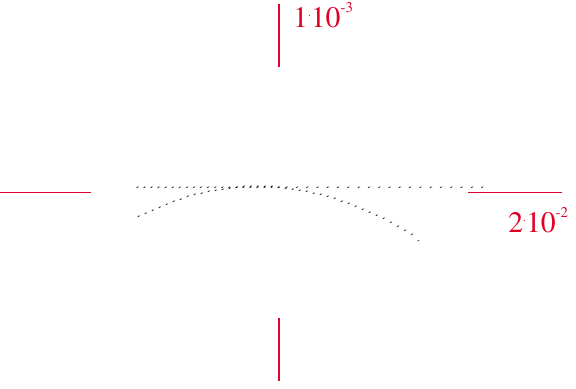
FIG. 8. (Color) Minimum longitudinal dispersion in the ring of FIRE after one revolution in the